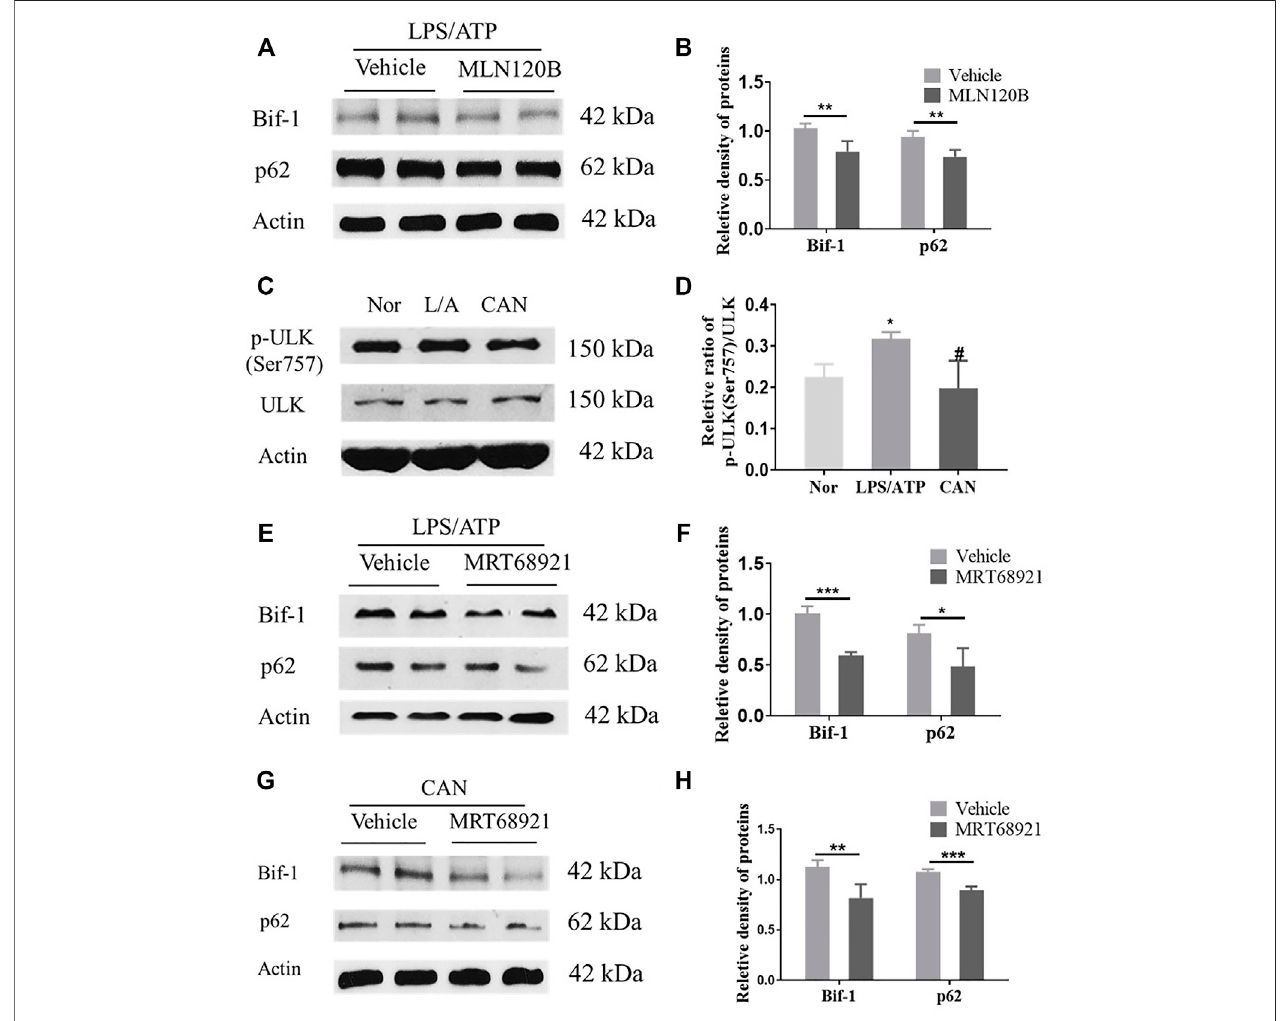
FIGURE4| Bif-1isregulatedbyNF- κ BandULK1. (A,B) J774A.1cellsweretreatedwithLPS(500 ng/ml)for6 hinthepresenceorabsenceofMLN120B(10 μ M), thenstimulatedwith5 mMATPfor30 min,proteinlevelsofBif-1andp62wereanalyzed. (C,D) CANinhibitsphosphorylationofULK1(Ser757). (E,F) J774A.1cellswere treated with LPS (500 ng/ml) for 6 h in the presence or absence of MRT68921 (1 μ M), then stimulated with 5 mM ATP, protein levels of Bif-1 and p62 were analyzed. (G,H) J774A.1 cells weretreated withLPS (500 ng/ml) andCAN (10 μ M) for6 h inthepresenceor absence ofMRT68921 (1 μ M), thenstimulatedwith 5 mM ATP, protein levels of Bif-1 and p62 were analyzed. Nor, normal control group; LPS/ATP (L/A), untreated LPS/ATP control group; CAN, CAN-treated LPS/ATP group. Data wereexpressedasmean±SD( n =3).Differenceswithaprobabilityvalueof < 0.05wereconsideredsigni fi cant. (B,F,G) ,* p < 0.05,** p < 0.01,*** p < 0.001; (D) * p < 0.05 vs. Nor; # p < 0.05 vs.